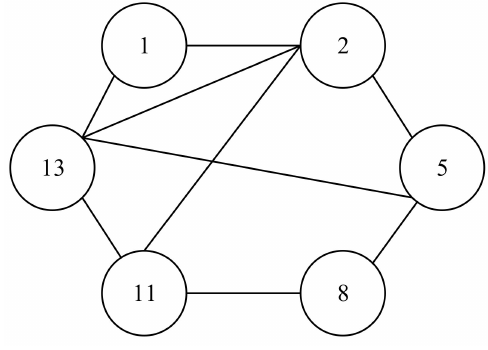
Figure 18. The IEEE 30-bus communication topology.